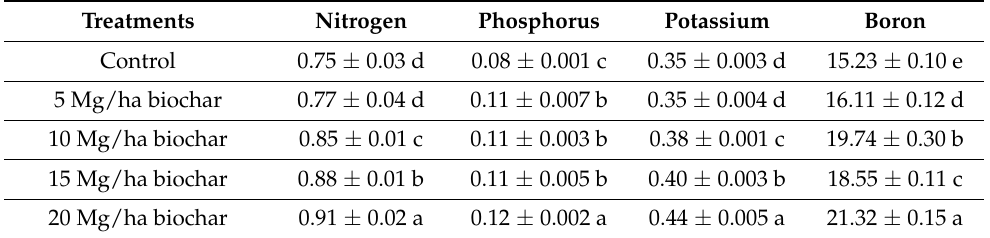
Figure 8. Effect of different biochar application rates on mango fruit TSS. Bars are mean of 9 replicates. Different letters show a significant difference at p ≤ 0.05 ( A ). Probability value hierarchy for fruit TSS is provided in ( B ). Table 1. Effect of different biochar application rates on leaf nutrient